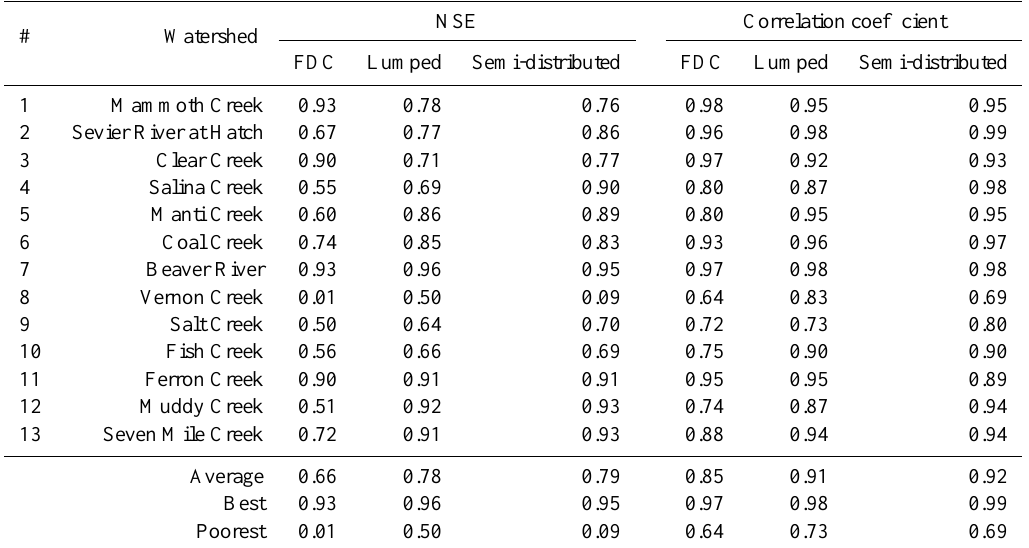
Table 3. NSE and correlation coefficient between field measurements and the three model